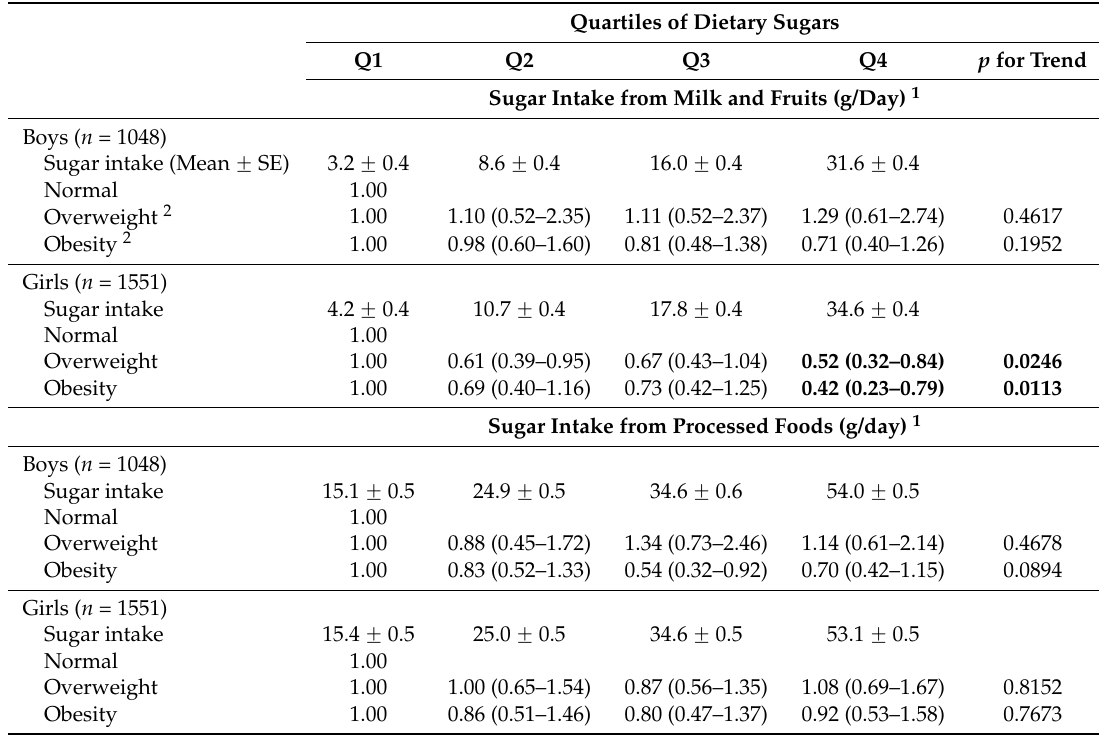
Table 3. Multivariate adjusted odds ratios (ORs) and 95% confidence intervals (CIs) for pediatric overweight and obesity across quartiles of dietary sugar intake based on food sources. Quartiles of Dietary Sugars Q1 Q2 Q3 Q4 p for Trend Sugar Intake from Milk and Fruits (g/Day)